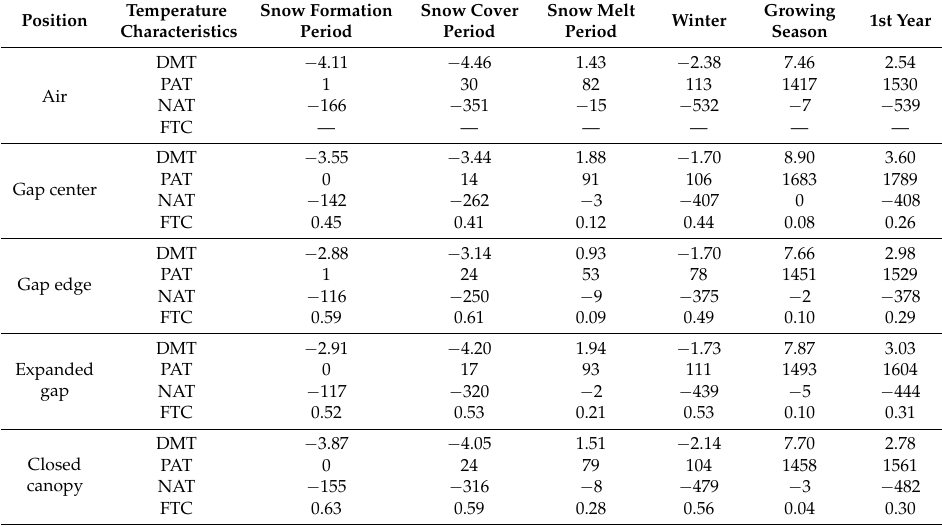
Table 1. Characteristics of the daily mean temperature (DMT, ˝ C), positive accumulated temperature (PAT, ˝ C), negative accumulated temperature (NAT, ˝ C) and the number of freeze-thaw-cycles per day (FTC, times) across each period of air and the four gap positions (gap center, gap edge, expanded gap, closed gap) over the first year of litter decomposition in an alpine Minjiang fir forest.